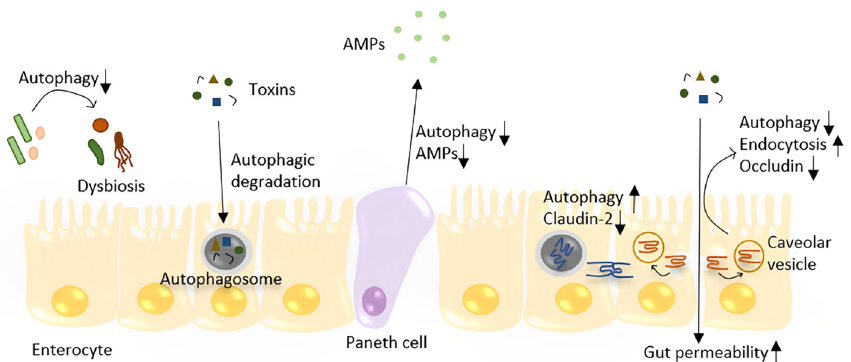
Figure 2. The role of autophagy in the maintenance of gut homeostasis. Autophagy plays a role in the defense against toxins and bacteria by directly degrading them in enterocytes. Autophagy regulates the TJ barrier through two different pathways: by degrading pore-forming claudin-2 and preventing occludin endocytosis, which prevents increased gut permeability. Depleting autophagy in the gut leads to dysbiosis. In Paneth cells, decreased autophagy may lead to less AMP production and Paneth cell apoptosis.